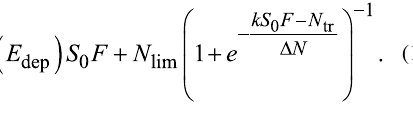
the growth rate during the last four simulation cycles in Figure